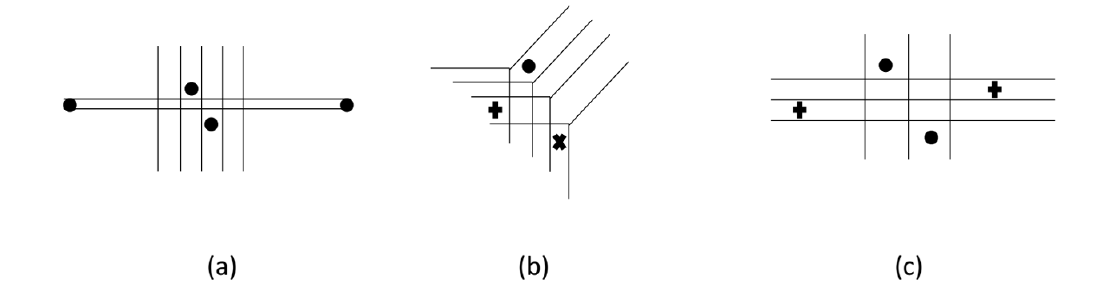
Figure 1 . The brane webs describing the e(cid:11)ective 5 d theory that results from the compacti(cid:12)cation of the previously discussed 6 d SCFTs. Speci(cid:12)cally, (a) is for the su (2) + 10 F SCFT, (b) for the su (3)+12 F SCFT and (c) for the su (4)+1 AS +12 F SCFT. Here we use black dots for D7-branes, black + for (0 ; 1) 7-branes and black X for (1 ; 1) 7-branes. The con(cid:12)guration are drawn such that they show the discrete symmetry permuting the (cid:13)avor symmetry, here manifested by a rotation in the plane of the web accompanied with the appropriate SL(2 ; Z )